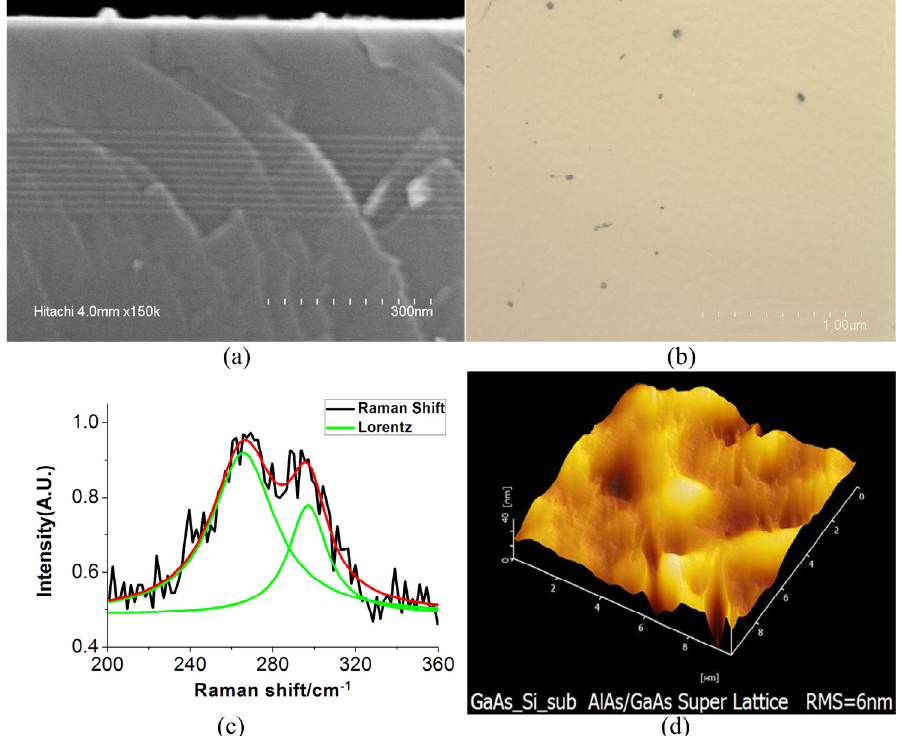
Figure 3. ( a ) The cross-section TEM image of optimized material; ( b ) the SEM image of EPD of optimized material; ( c ) Raman spectra measured of optimized material using Lorentz fit; and ( d ) the AFM image of optimized